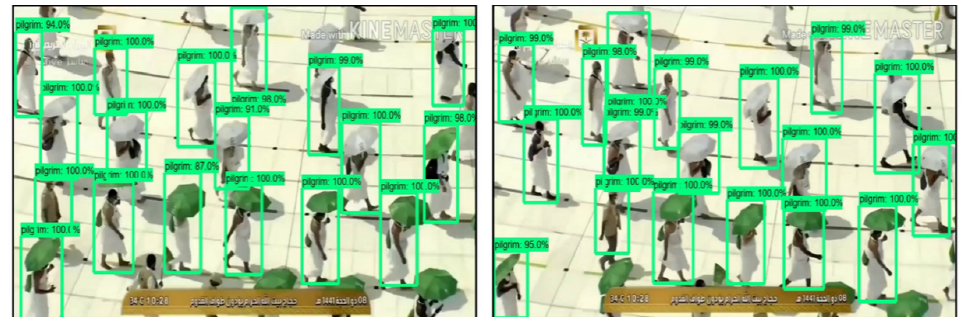
Figure 2. Visual representation of YOLOV4 model on pilgrim’s dataset.